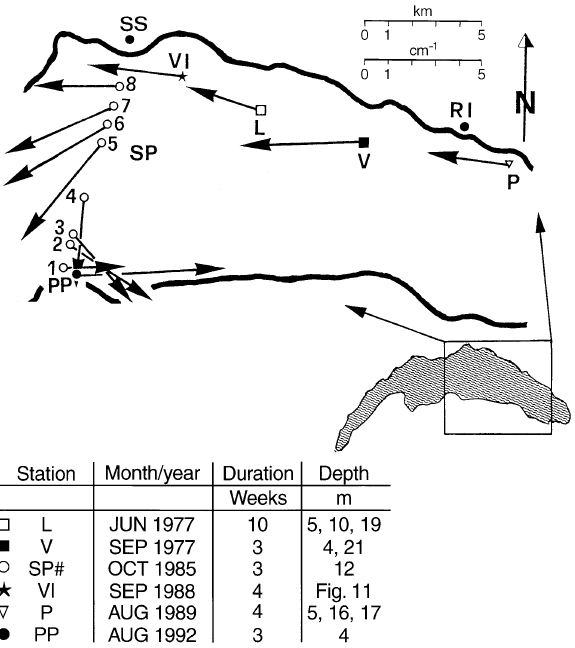
Fig. 10. Mean current vectors recorded at around 10 m depth in the central basin of Lake Geneva. The year and the duration of each campaign and depths of measurement are indicated. Data at stations SP1 to SP8 were recorded simultaneously. For depths at station VI refer to Fig. 11. The area of measurements on the lake has been indicated in the inset at right bottom